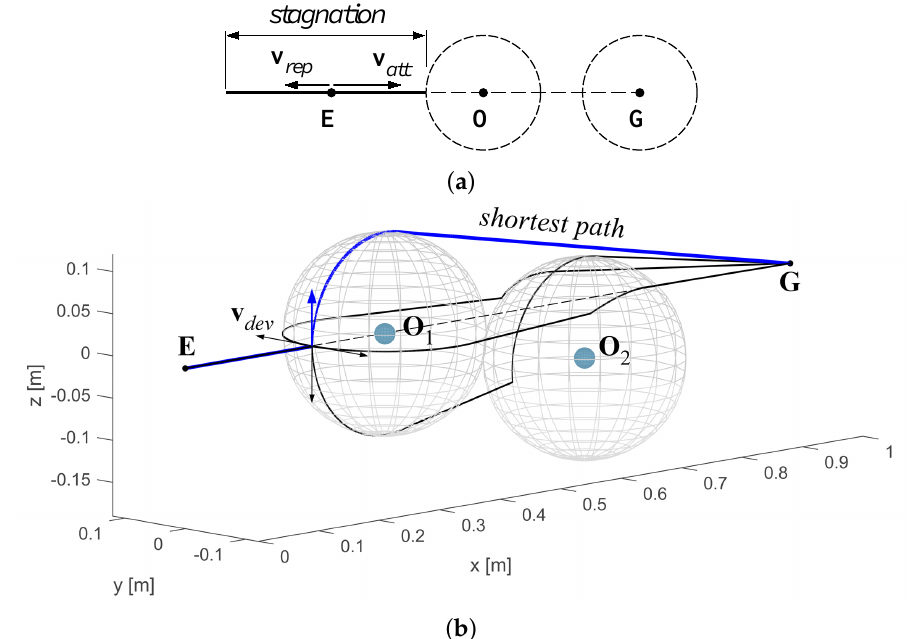
Figure 4. ( a ) Alignment condition between end-effector, obstacle and goal in a simplified 2D repre- sentation; ( b ) example of trajectories generated by different directions of v dev in the 3D